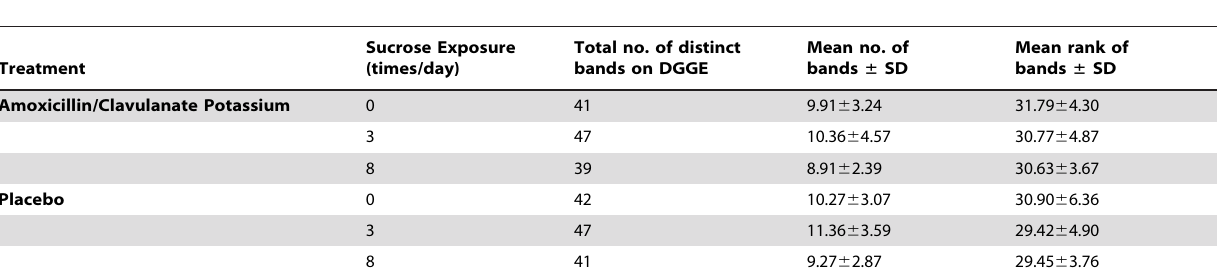
Table 2. Mean number and mean rank of bands according to treatments (amoxicillin/clavulanate potassium or placebo) and daily frequency of sucrose exposure (0 – no exposure; exposure – 3 or 8 times/day).